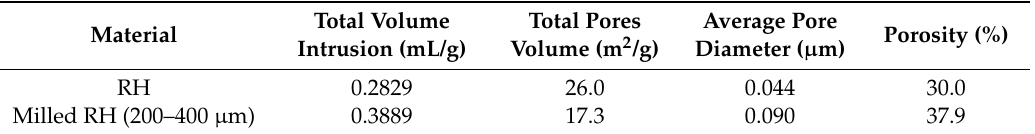
Table 1. Comparison of porosity of RH before and after milling. Data were obtained by means of mercury intrusion